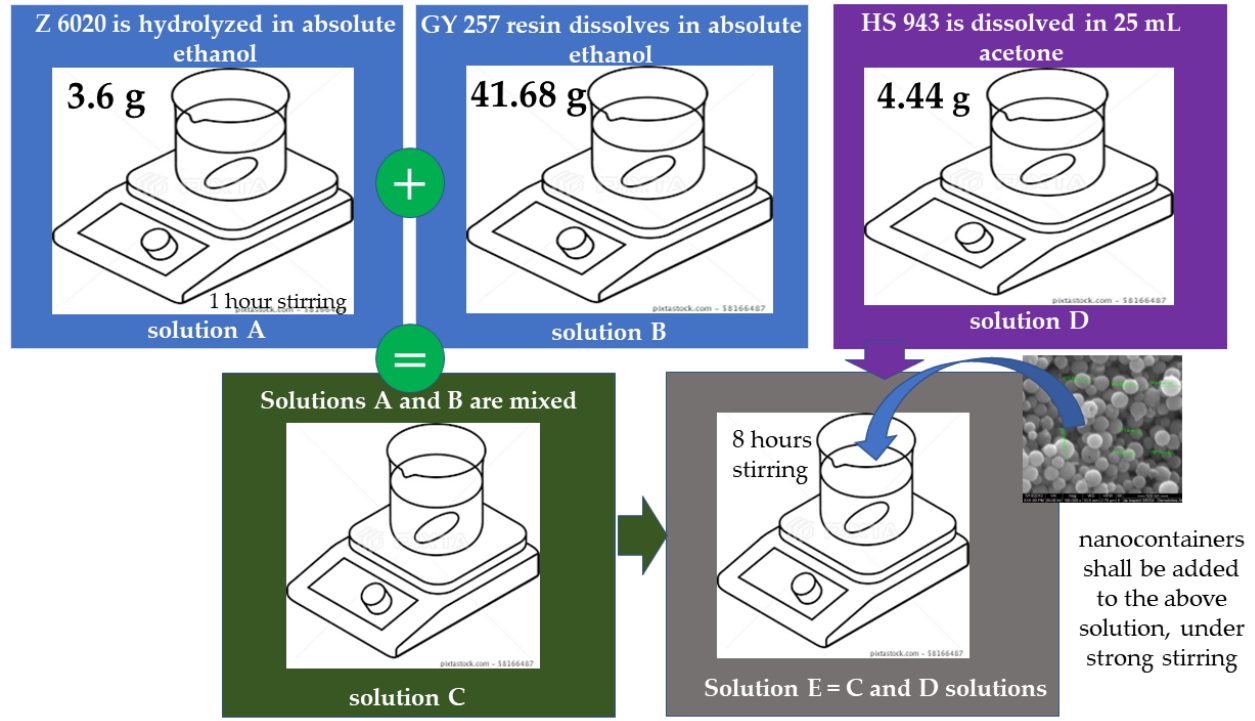
Figure 2. An example of CBC synthesis using the ORMOSIL method. Z 6020: N-(2-aminoethyl)-3- (trimethyloxypyl) propylamine, GY-257: phenol 4,4 ’ -(1-methylethylidene) bis-, HM 943: triethylenetetramine.